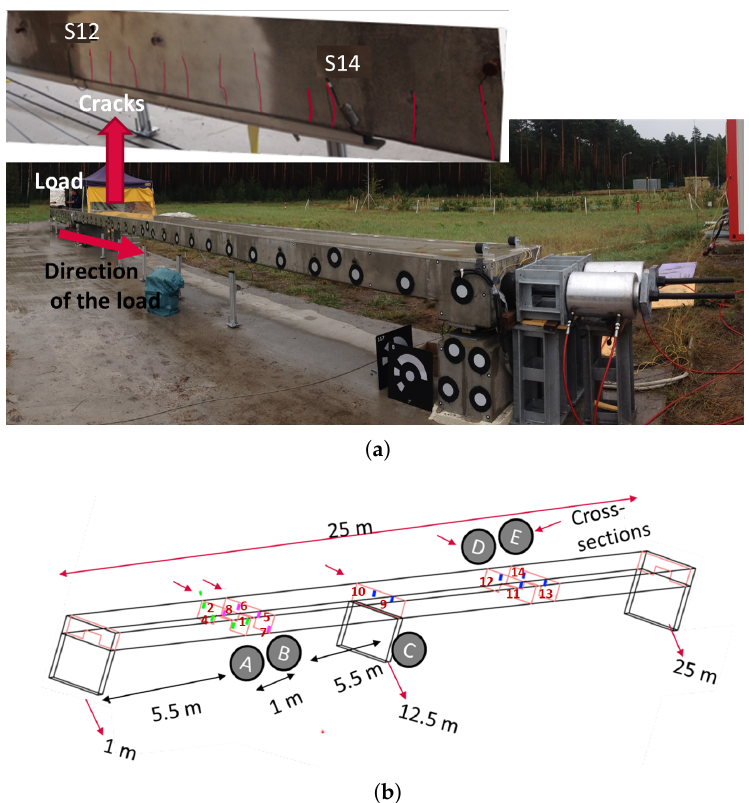
Figure 3. The BLEIB reference structure and sensors distance from each other in the BLEIB refer- ence structure. ( a ) BLEIB reference structure, load direction, and location of cracks; ( b ) Ultrasonic sensor position and distance inside the BLEIB reference